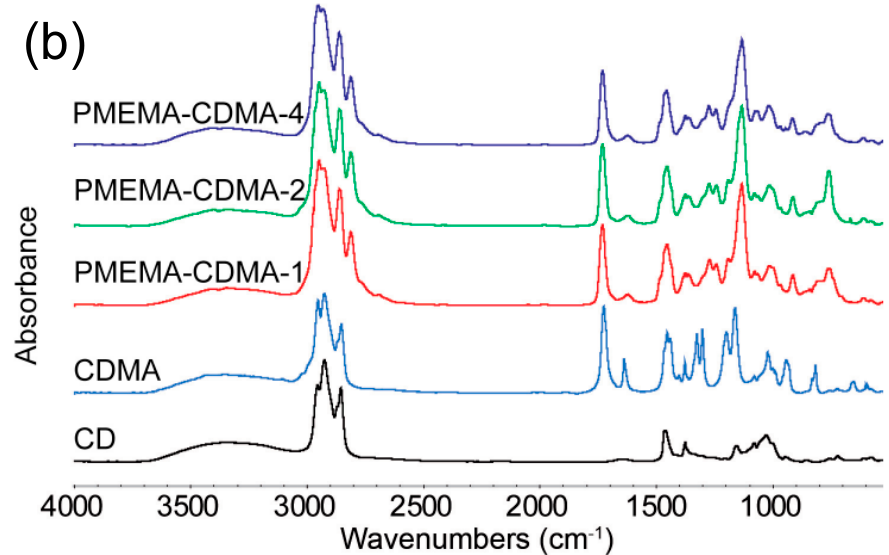
Figure 1. 1 H NMR spectrum of CDMA ( a ); FTIR spectra of β -cyclodextrin (CD), CDMA, and PMEMA–CDMA brush-gels ( b ).